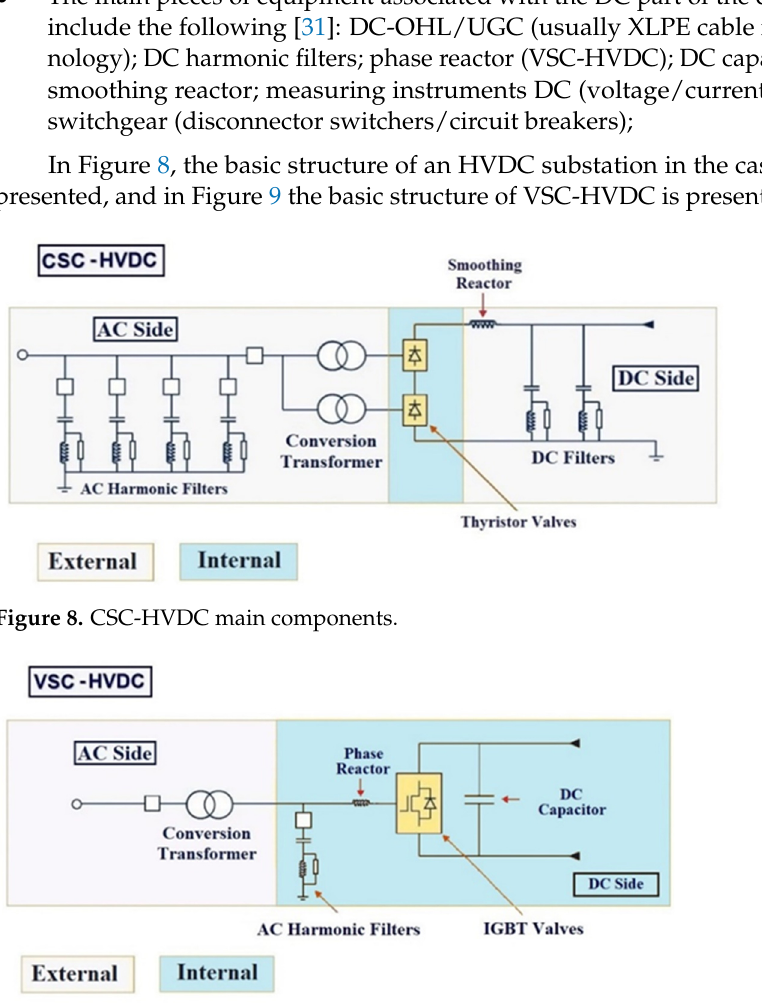
Figure 9. VSC-HVDC main components.